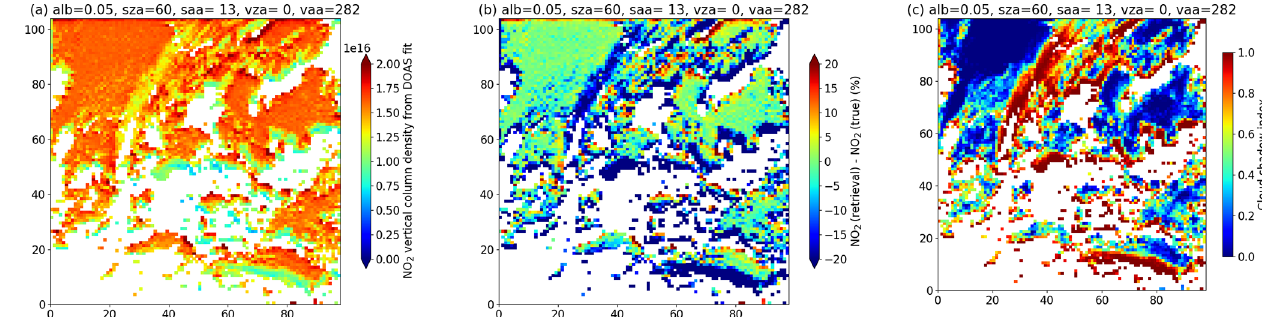
Figure 1. (a) The retrieved NO 2 TVCD for the low-earth-orbit geometry case, with albedo = 0.05, solar zenith angle = 60 ◦ , solar azimuth angle = 13 ◦ , satellite viewing angle = 0 ◦ , and satellite azimuth angle = 282 ◦ (identical for all pixels). (b) The difference between the retrieved and the true NO 2 TVCD. (c) The cloud shadow index; see Sect. 3.3 for details. The units on the axes are pixel numbers. White pixels are cloudy regions for which the retrieval was not